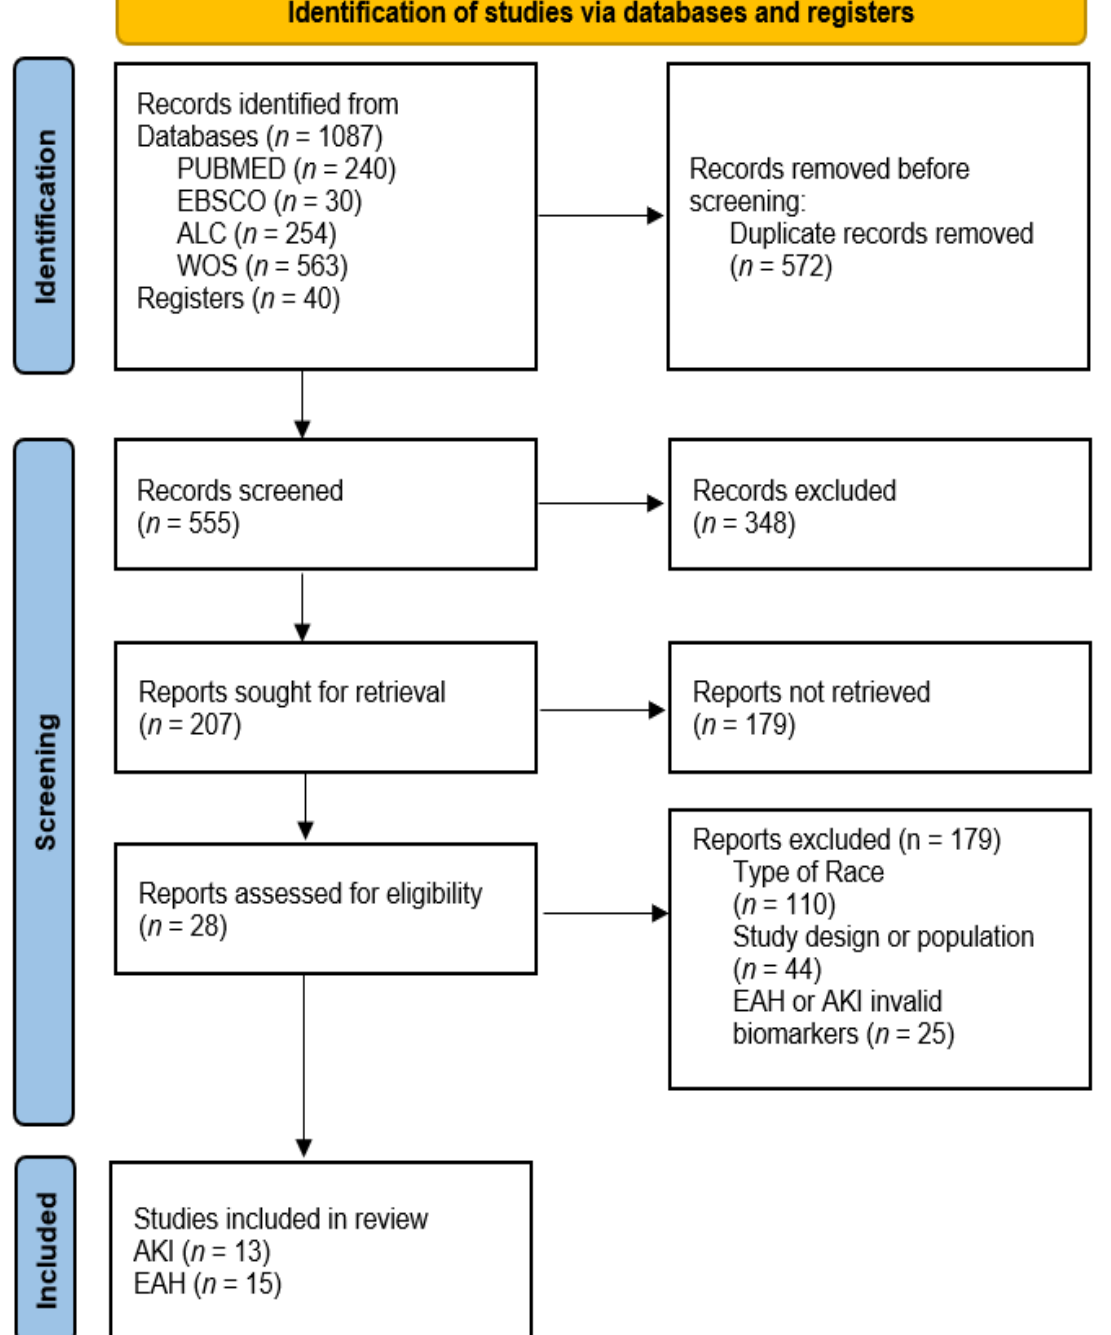
Figure 1. Flow chart describing the selection process of the included studies [38].